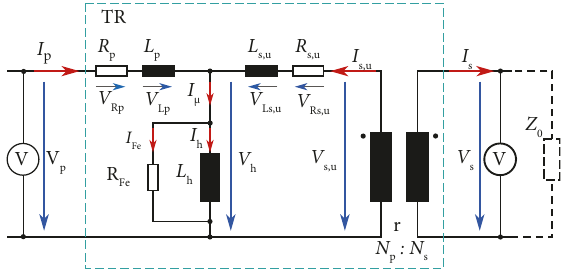
Figure 7: Equivalent circuit diagram of a real transformer TR regarding parasitic elements for loss and magnetization effects. Values with indexes s, u are referred to primary side with trans- former ratio r